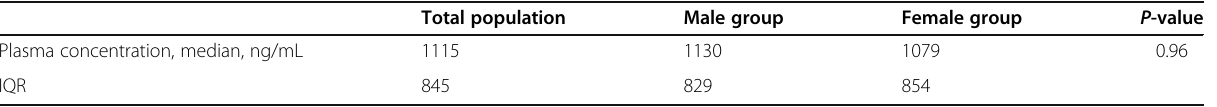
Table 5 Plasma concentration of TSP-1 distributed in the total population, and in the two genders Total population Male group Female group P -value Plasma concentration, median,